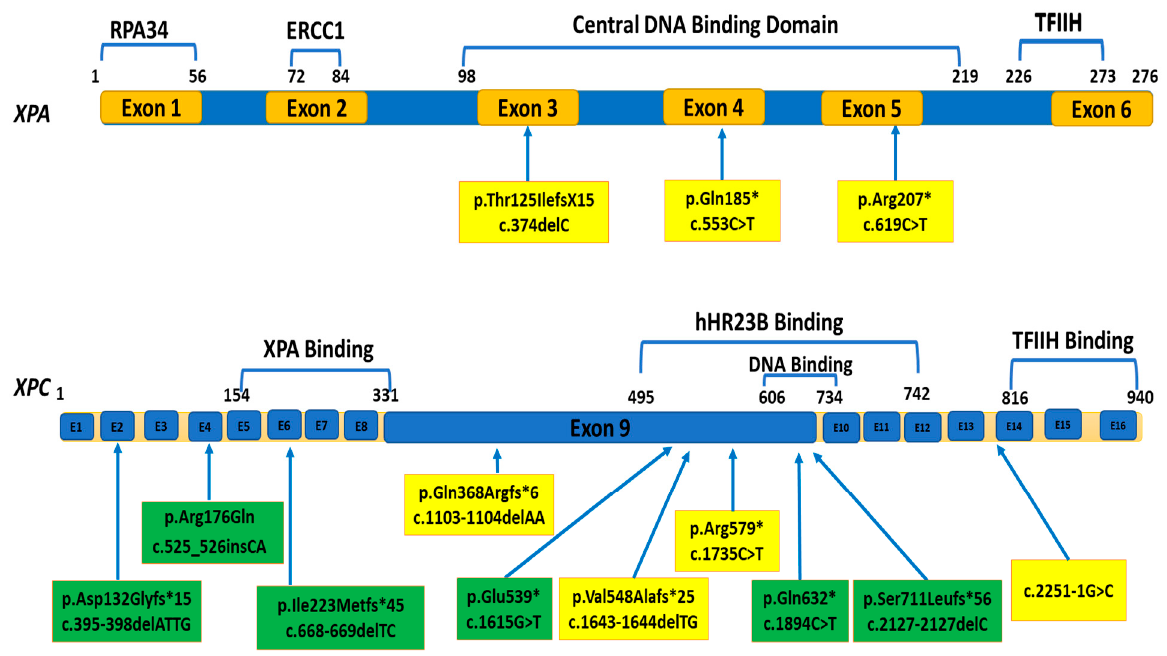
Figure 1. Mutations of XPA and XPC genes identified in our cohort. The figure shows XPA and XPC genes, exons and their corresponding protein domains (above each gene). Numbers refer to amino acid positions. XPA has six exons encoding 276 amino acids. XPC has 16 exons encoding 940 amino acids. Thirteen mutations were identified: six novel mutations (green boxes) and eight previously reported mutations (yellow boxes). XPA mutations were identified in exons 3–5 which encode DNA binding domain. Exon 9 of XPC was more frequently mutated. ERCC1: excision repair cross complementing gene 1; hHR23B: human homolog of the yeast RAD23B protein; TFIIH: transcription factor IIH.